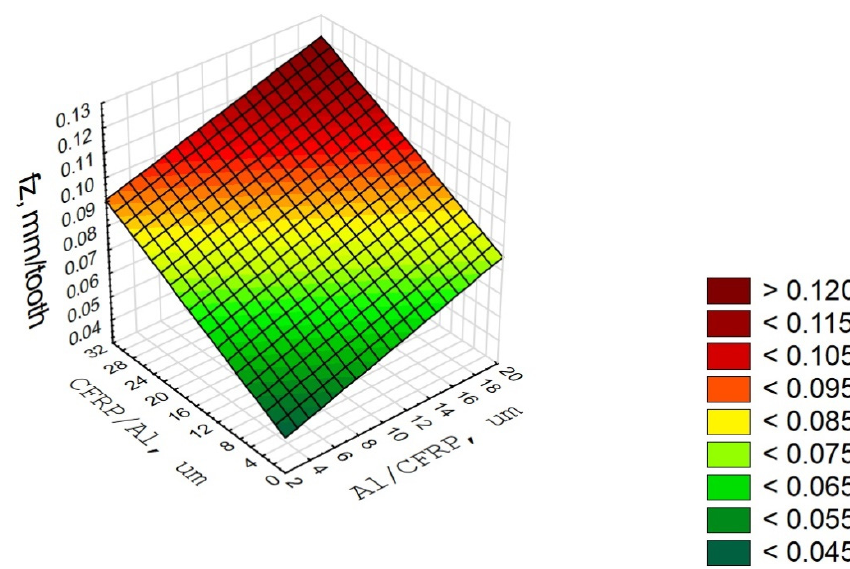
Figure 12. Diagram of correlation and multiple regression for f z parameter. Table 9. Results of statistical analysis for f z variable during milling from aluminum alloy layer (Al / CFRP)